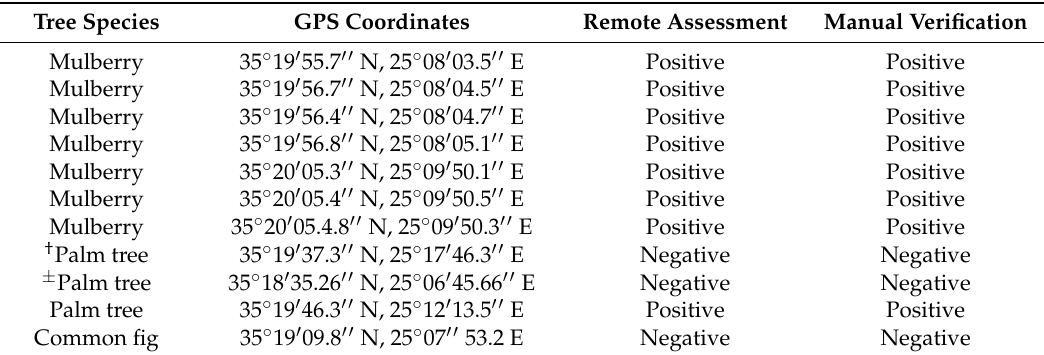
Table 1. Field application using the suggested device in the city of Heraklion in Crete. All trees have been partially or totally cut down, sliced and examined. Mulberries and the common fig have been checked for the presence of X. chinensis and palm trees for R. ferrugineus. † ± two cases correctly classified as negative contradicting visual